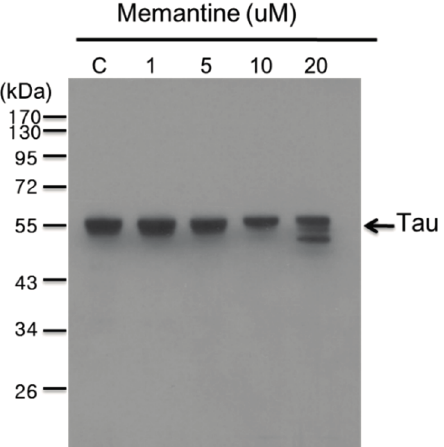
Figure 5. Western blot analysis showing the effect of memantine on tau protein expression in the rat hippocampal cell lysate. The hippocampal cells (5 × 10 4 /cm 2 ) were treated with different concentrations of memantine (1, 5, 10 and 20 μ M). The PVDF membrane was incubated with anti-tau-1 (clone PC1C6) antibody to identify the endogenous tau protein from N2A cells. Each lane corresponds to the concentration (1–20 μ M) of memantine treatment; Lane C is for the untreated cell lysate. Tau protein is visible as bands in between the 43 and 55 kDa regions. Molecular weight marker is shown left